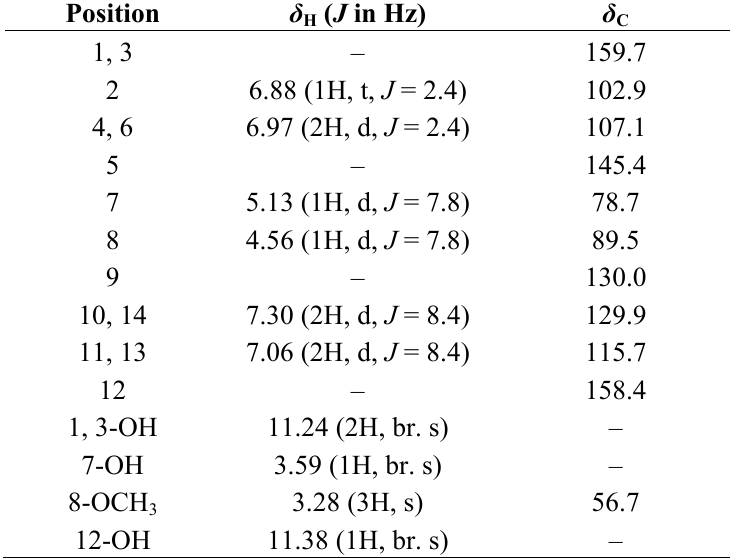
Table 5. 1 H-NMR (600 MHz) and 13 C-NMR (150 MHz) spectra data of compound 6 D N, J in Hz, δ in (in C 5 5